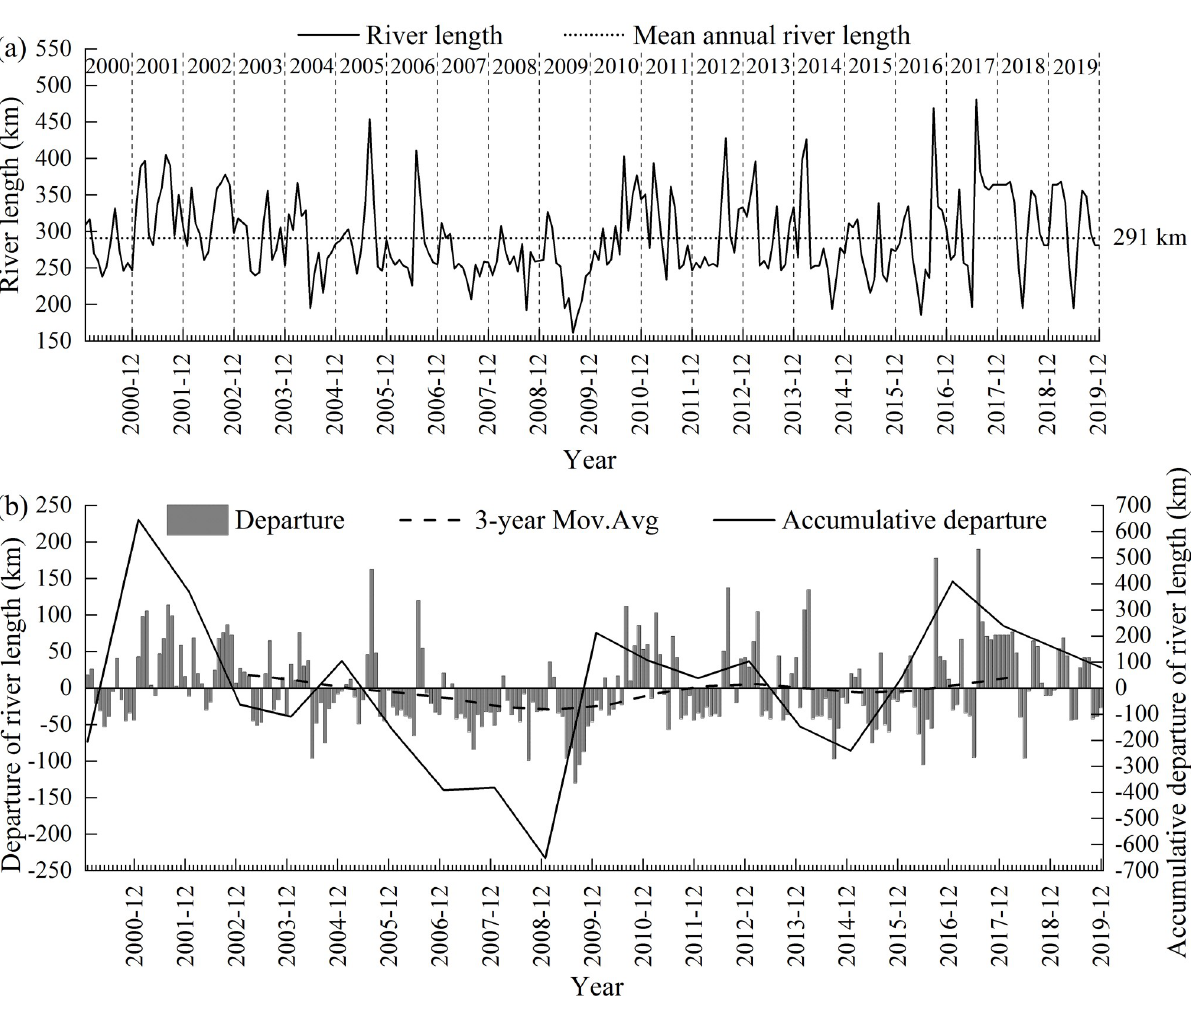
Fig 6. Observed changes in river length measured along the lower reaches of the Keriya River between 2000–2019 (a) and departures, accumulative departure and 3-year moving average of river length from 2000 to 2019 (b). The horizontal axis (X-axis) tick marks show months for each year.